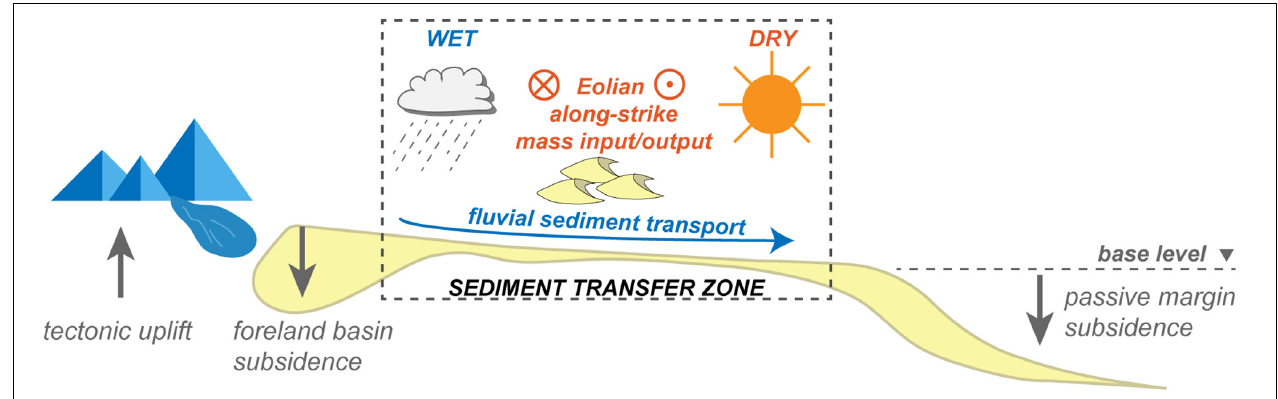
FIGURE 1 | Schematic 2-D profile of the Andean-to-Atlantic margin sediment-routing system of central Argentina emphasizing erosion, transfer, and accumulation zones and important controls of tectonics, climate, base level, and along strike along-strike eolian processes (modified after Romans et al., 2016).